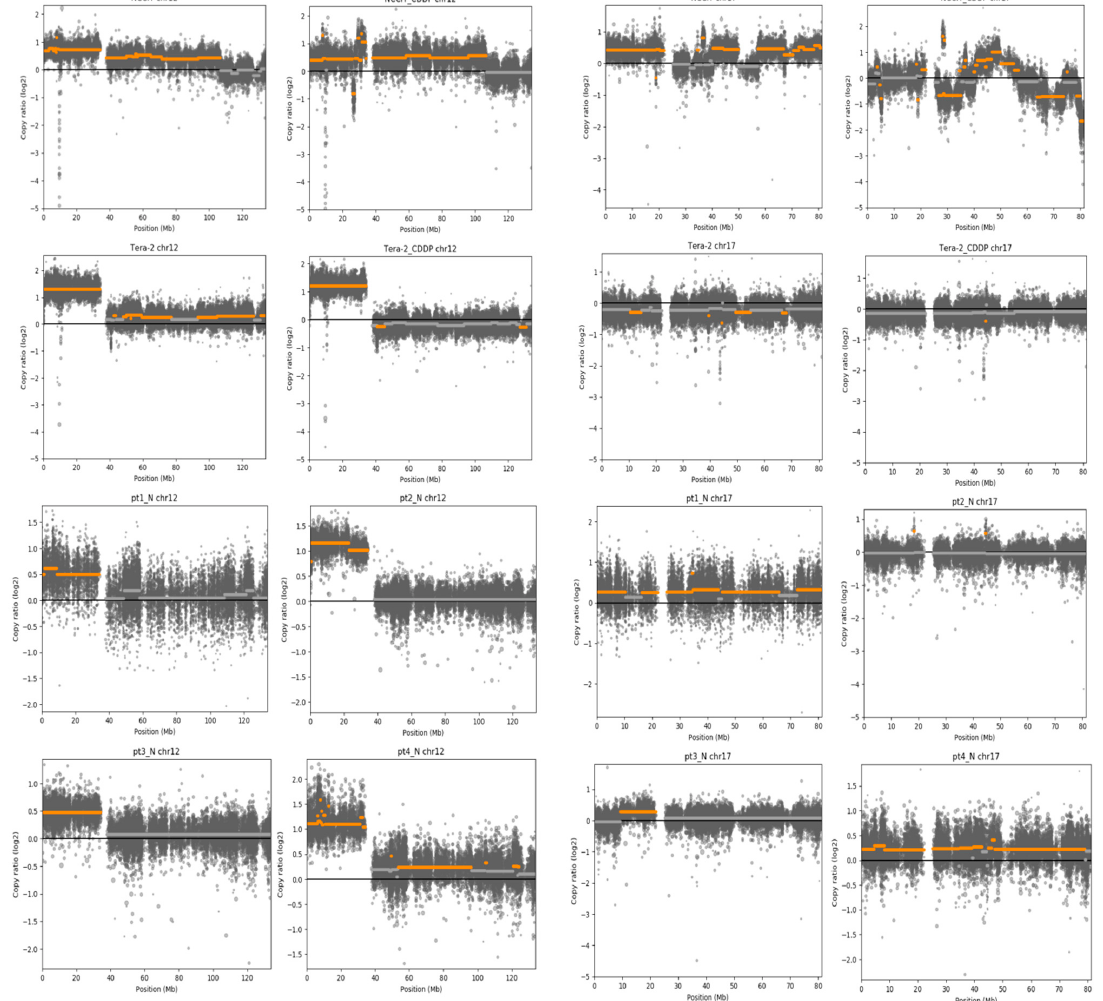
Figure 4. Scattered plots displaying copy number variation ratios inferred from WES data normalized to pooled control samples. Segmental changes with predicted copy number alteration are marked in orange, normal in gray. Chromosomes 12 and 17 as the most clinically relevant displayed here, all are in the supplementary material (Supplementary Figure S2).